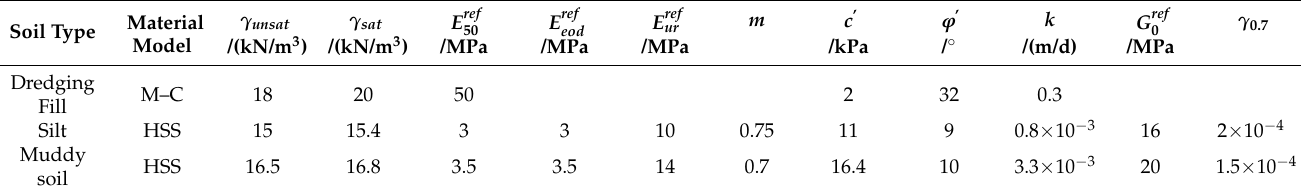
Table 3. Soil layer material parameters.